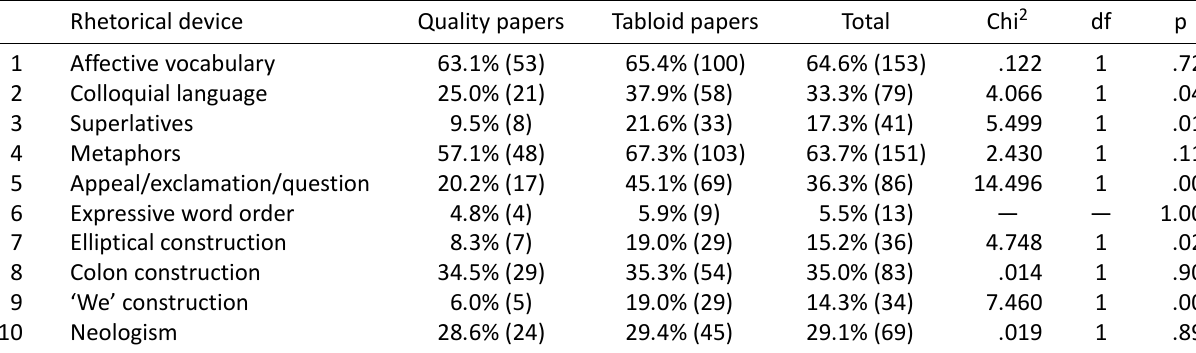
Table 4. The use of rhetorical devices in quality and tabloid papers.